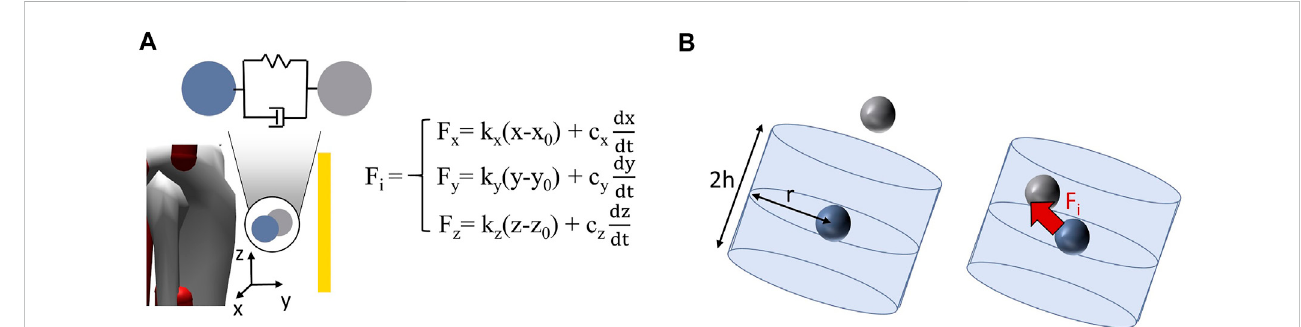
FIGURE 4 Identi fi ed approaches for simulating the occurring interaction force at the interface between DHM und WAD based on the contact models (A) based on the deviation of the two contact nodes and the calculation of the force via a spring-damper system (B) based on the integration of the device node in the cylindrical area around the model node and generation of the force; blue indicates the node of the DHM, grey indicates the node of the WAD.